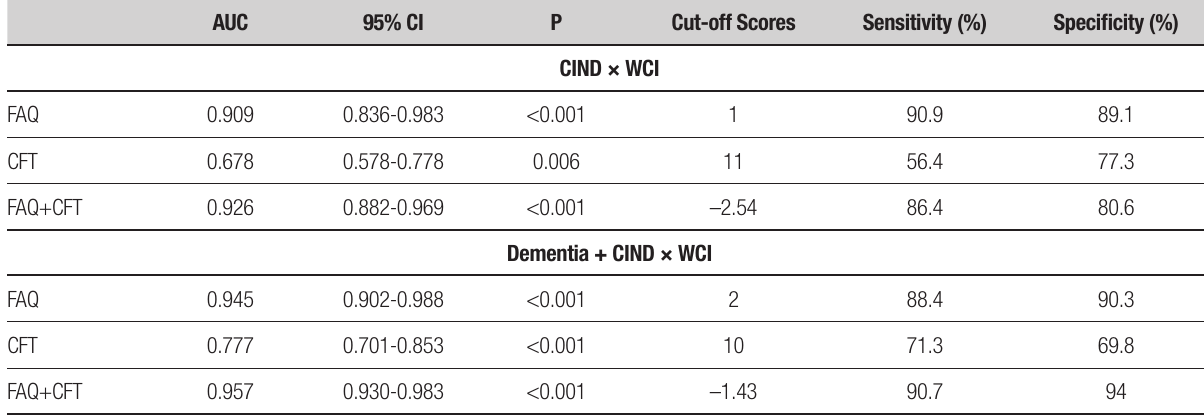
Table 2. Sensitivities and specificities of FAQ, CFT, and FAQ combined with